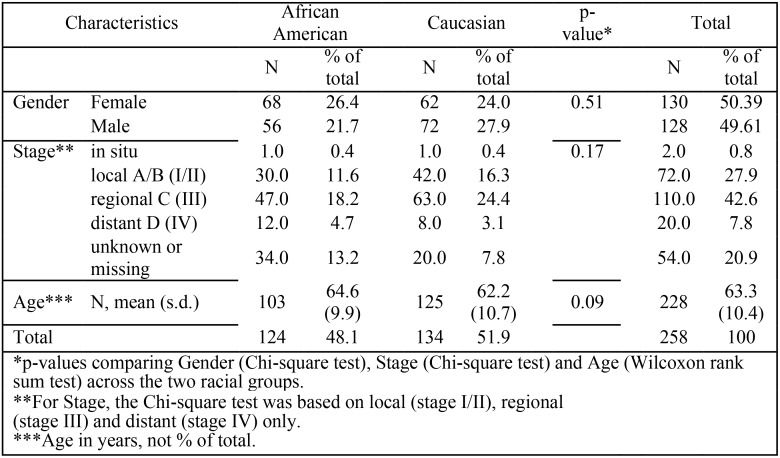
Characteristics of study participants by race.The 258 colon cancer samples from the NCCCS used in this study are described by race, gender, stage and age.